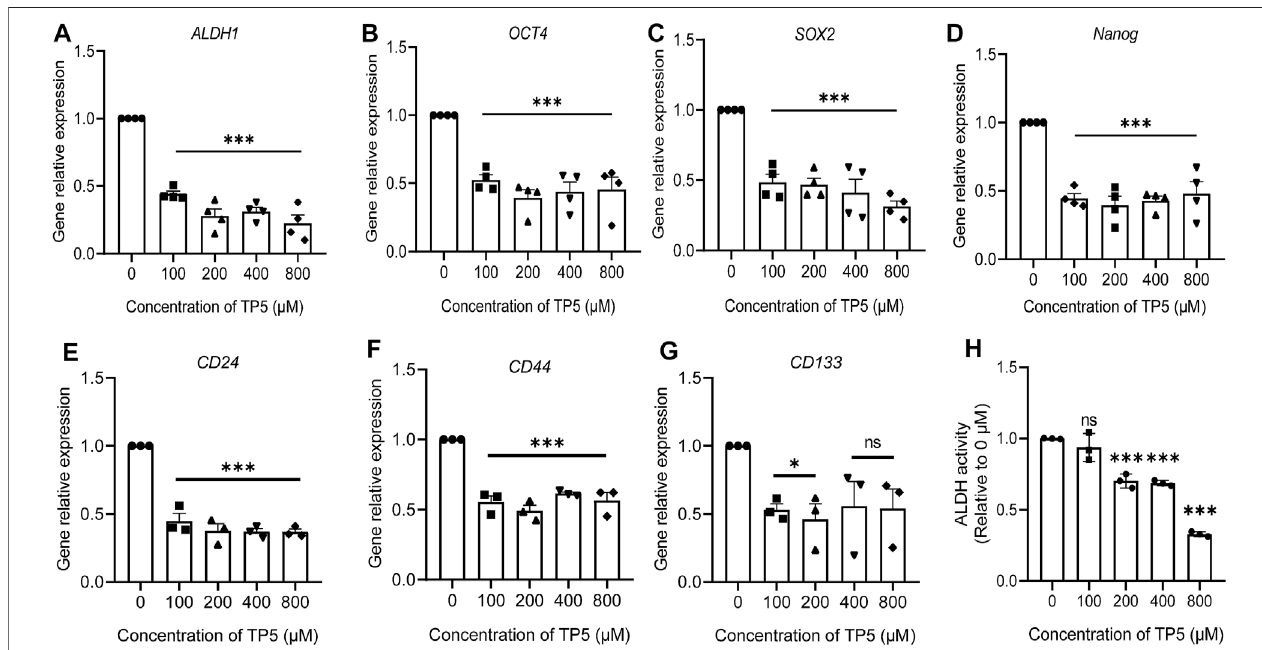
FIGURE 3 | TP5 reduced the expression of cancer stem cell-related genes in HCT116 cells. (A – G) RT-qPCR analysis of relative mRNA expression of CSC- associated genes ALDH1 (A) , SOX-2 (B) , Oct-4 (C) , Nanog (D) , CD24 (E), CD44 (F ) and CD133 (G) in HCT116 cells. (H) ALDH activity before and after treatment with different concentrations of TP5 ( n = 3 – 4 independent experiments). All data are expressed as mean ± SD; * p < 0.05 and *** p < 0.001 vs. control, one-way ANOVA with Dunnett ’ s post hoc test, (A) , F (4, 15) = 63.02, p < 0.0001, (B) , F (4, 15) = 17.52, p < 0.0001, (C) , F (4, 15) = 22.74, p < 0.0001, (D) , F (4, 15) = 22.83, p < 0.0001, (E) , F (4, 10) = 3.392, p = 0.0533, (F) , F (4, 10) = 53.61, p < 0.0001, (G) , F (4, 10) = 29.41, p < 0.0001, (H) , (F (4, 10) = 83.55, p < 0.0001; ns, not signi fi